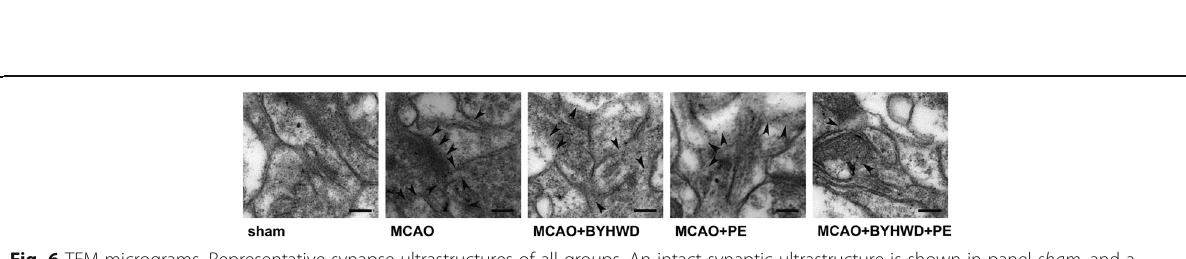
Fig. 5 Expression levels of SYN (SYN-1), GAP-43 and MAP-2 in all groups at each time point. The proteins expression levels at each time point following the MCAO are presented in representative western-blotting autoradiograms ( a ). We detected SYN at 77 kDa, GAP-43 at 48 kDa, MAP-2 at 70 kDa and the β -actin loading control at 43 kDa. Lane 1, sham group; Lane 2, MCAO group; Lane 3, MCAO + BYHWD group; Lane 4, MCAO + PE group; Lane 5, MCAO + BYHWD + PE group. The quantitative analyses ( n = 6) of the western blot results for the expression levels of SYN, GAP-43 and MAP-2 are presented in the bar graphs ( b ). The bars indicate the means ± standard errors of the means. *, p < 0.05, compared to the MCAO group